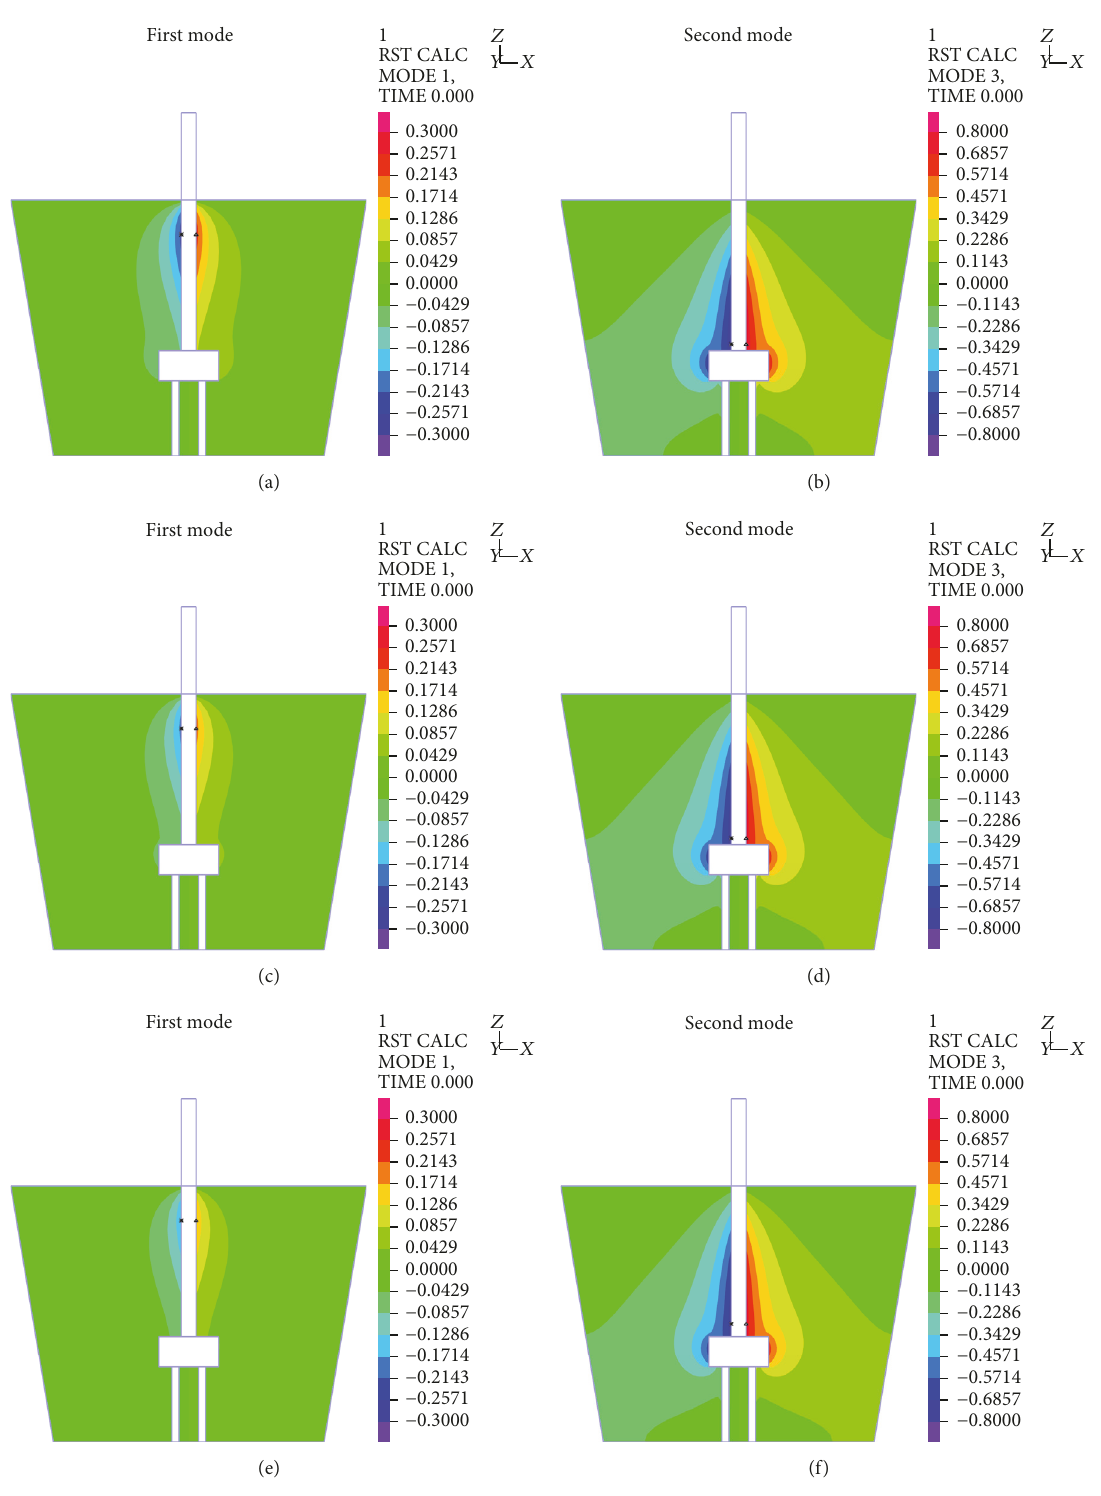
Figure 21: Nondimensional modal hydrodynamic pressures on the pier specimen in the first two modes along 𝑥 -axis, with a water level, 𝐻 w , of 1.8 m, along 𝑦 = 0 m cutting plane, corresponding to a tip mass of (a) and (b) 12.1kg; (c) and (d) 23.4 kg; (e) and (f) 31.7